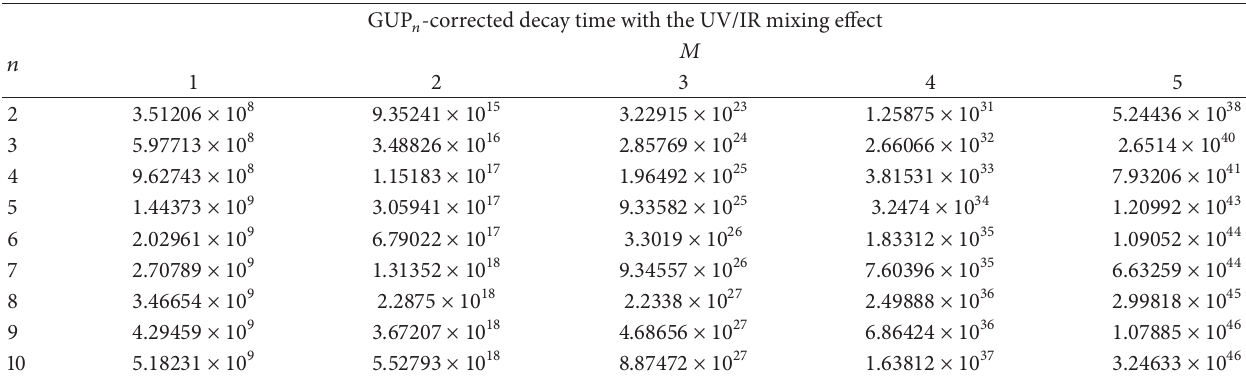
Table 4: GUP 𝑛 -corrected decay time with 𝑛 = 2, 3, .. ., 10 , the black hole mass 𝑀 = 1, 2, .. ., 5 (in Planck units), and 𝛼 = 1 . GUP 𝑛 -corrected decay time with the UV/IR mixing